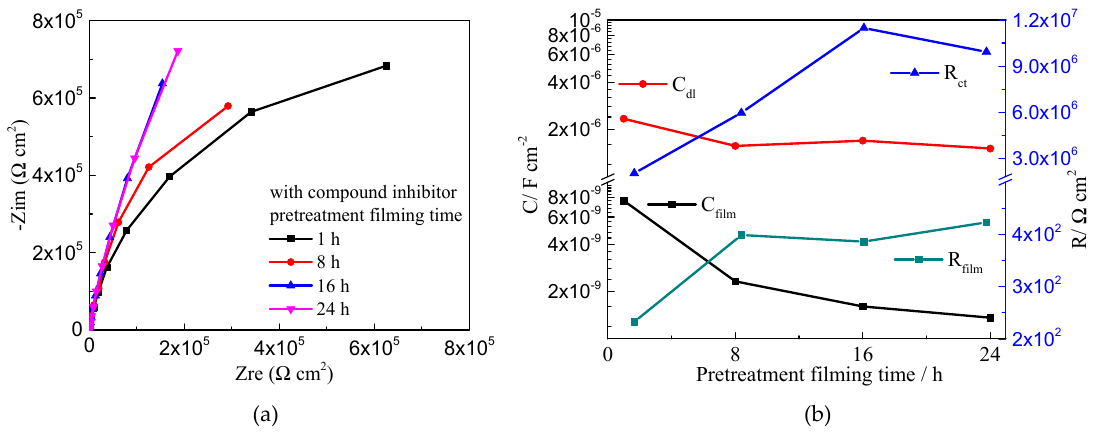
Figure 7. Nyquist polts ( a ) and EIS parameters ( b ) of Q235 steel in test solution with different pretreatment filming time.